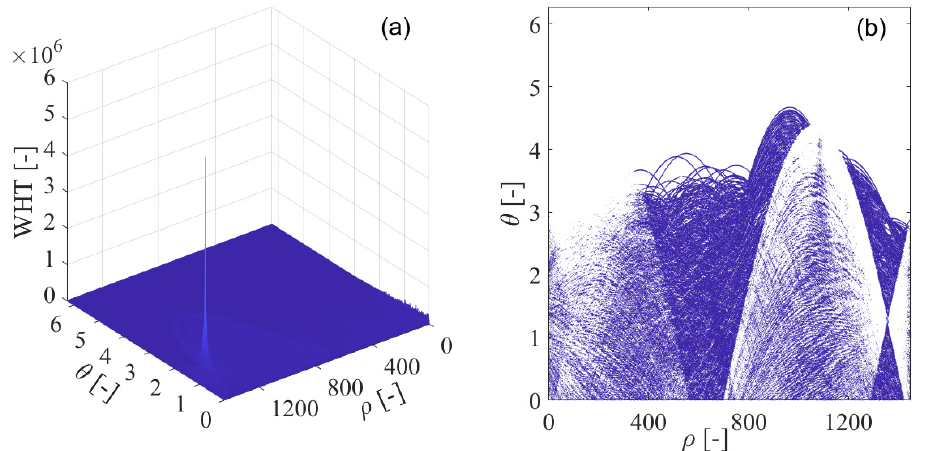
Figure 11. The Wigner–Hough transform (WHT) of the GPS L1-C/A signal disturbed by sweep interference; ( a ) WHT; ( b ) WHT’s contour. interference; ( a ) WHT; ( b ) WHT’s